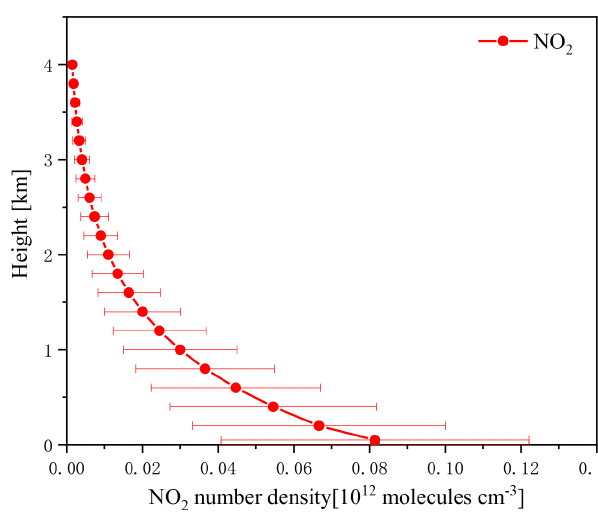
Figure 14. The a priori NO 2 profiles used by PriAM for the NO 2 retrieval in this study. The error bars represent the a priori uncer-